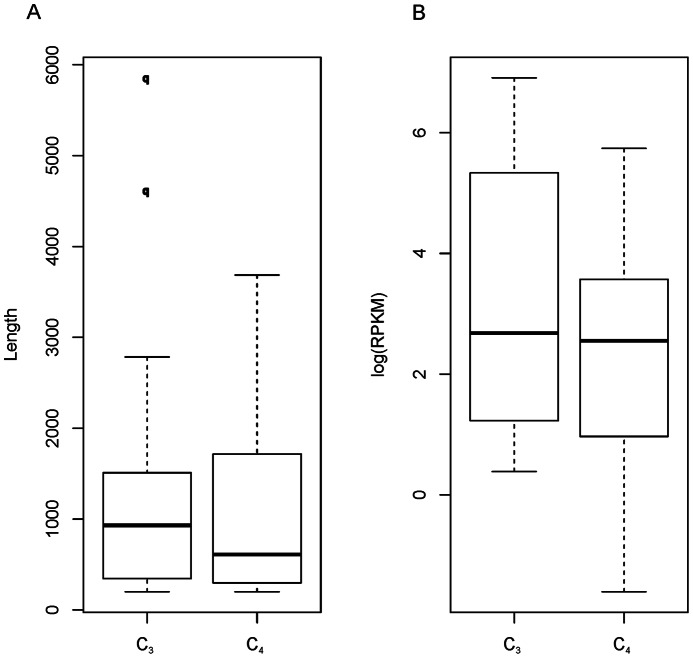
Boxplot distribution of C3 and C4 unigenes.(A) Length distribution inferred with log(Length). (B) Expression level inferred by log(RPKM) value.